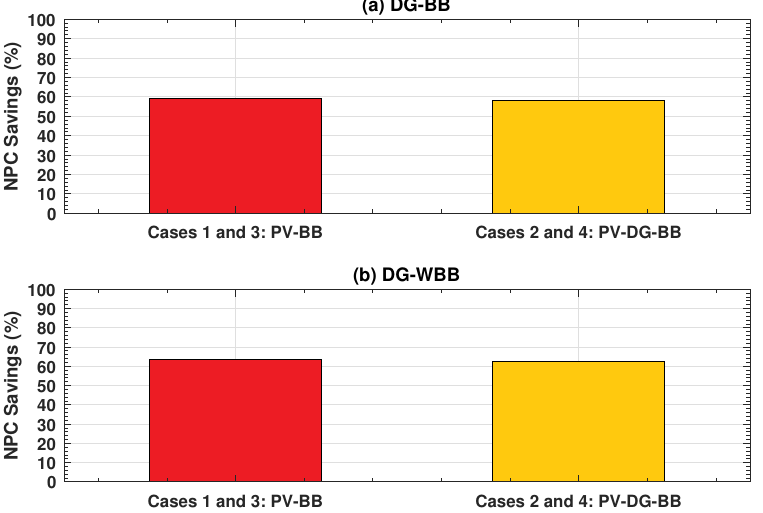
Figure 11. NPC savings of Wafra cell-site with respect to the ( a ) DG-BB and ( b ) DG-WBB